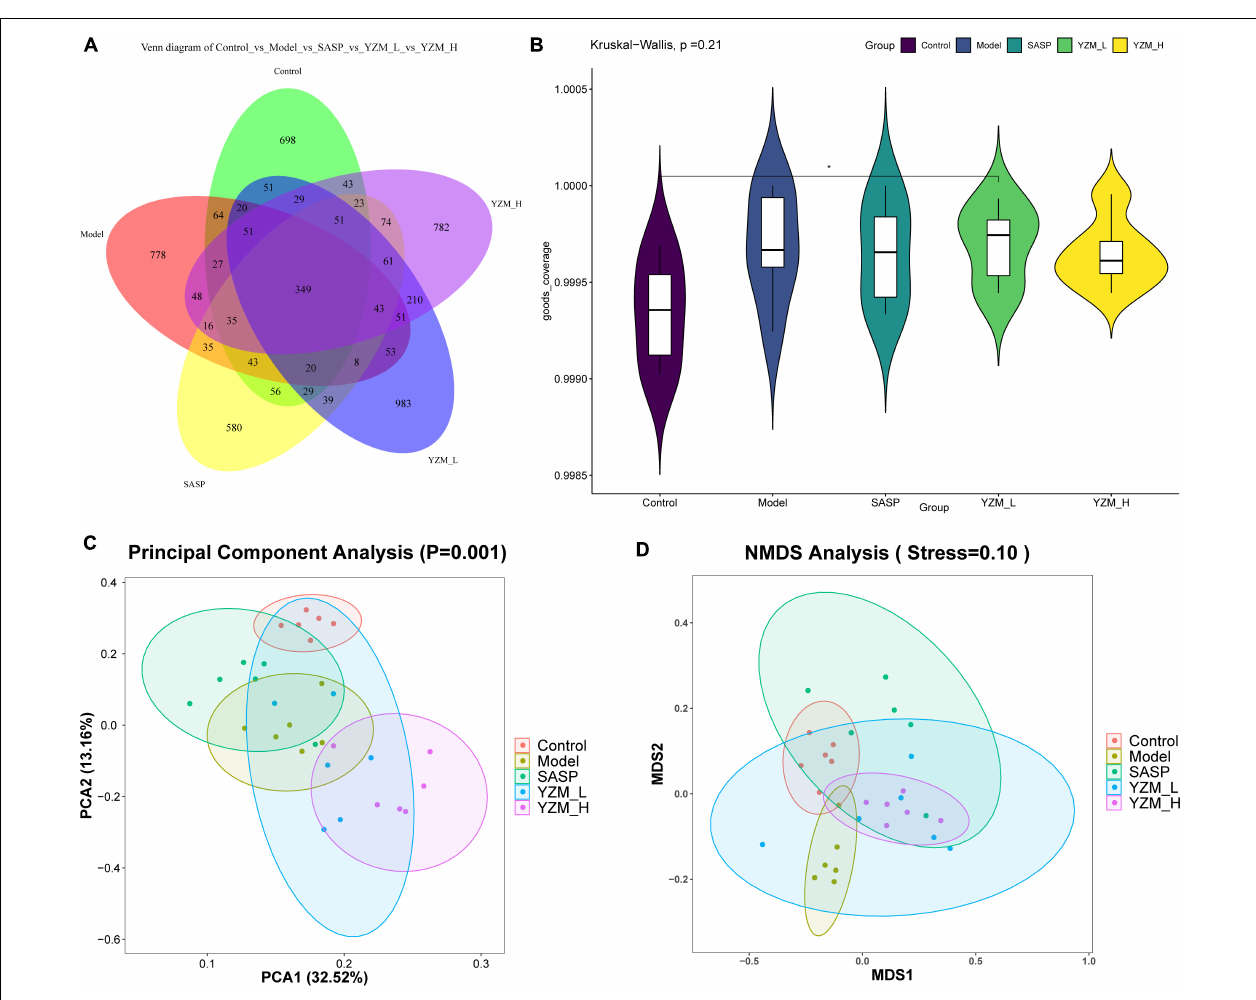
FIGURE 4 | Effects of YZM on intestinal microbiota. (A) The cluster analysis. (B) The alpha diversity, (C) PCA. (D) NMDS. * p < 0.05 vs.